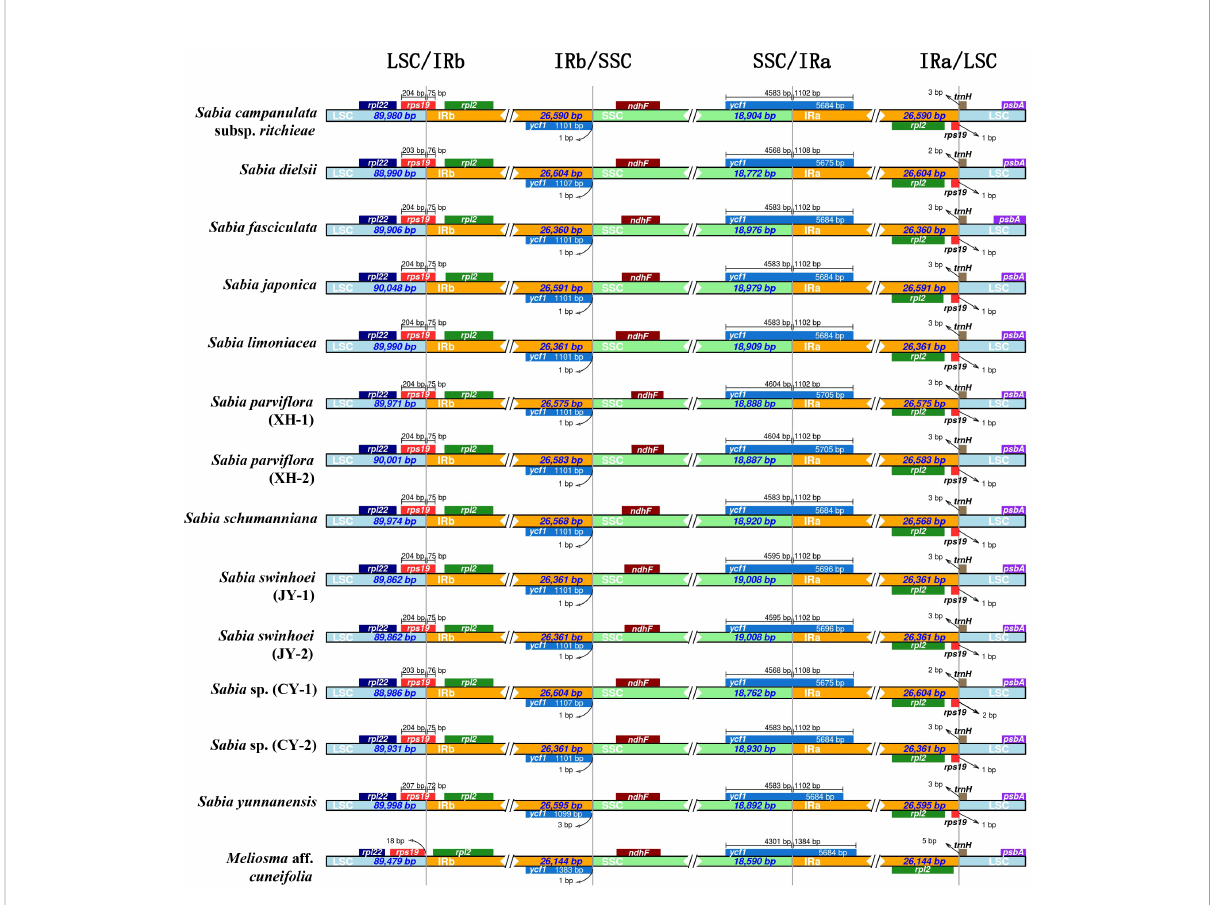
FIGURE 2 Comparison of small single-copy region (SSC), large single-copy (LSC), and inverted repeat regions (IRa and IRb) boundaries in 14 chloroplast genomes of Sabiaceae. LSC/IRb, IRb/SSC, SSC/IRa, and IRa/LSC denote the junction sites between each corresponding two regions of the